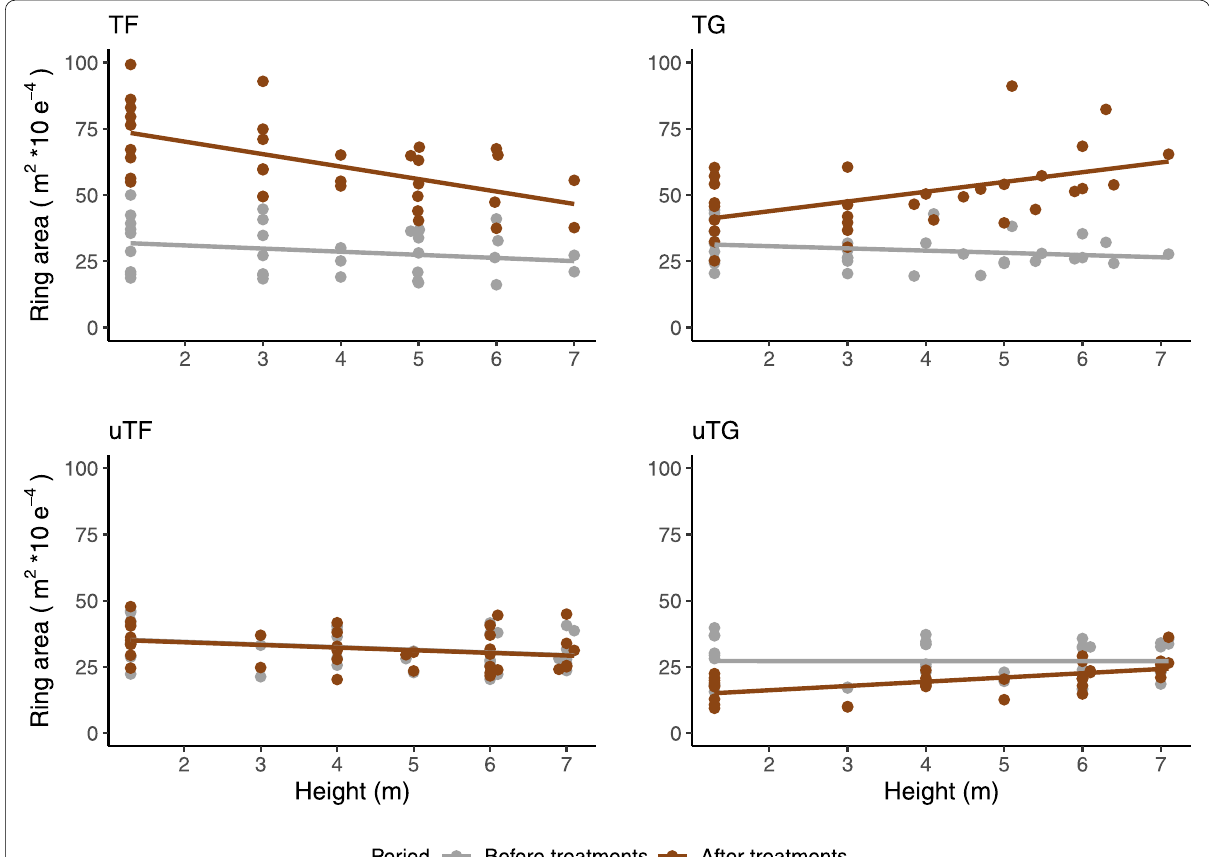
Fig. 4 Variation in ring area below the guy-wiring height related to tree height for each treatment. TF stands for thinned free-swaying trees, TG for thinned guy-wired trees, uTF for unthinned free-swaying trees and uTG for unthinned guy-wired